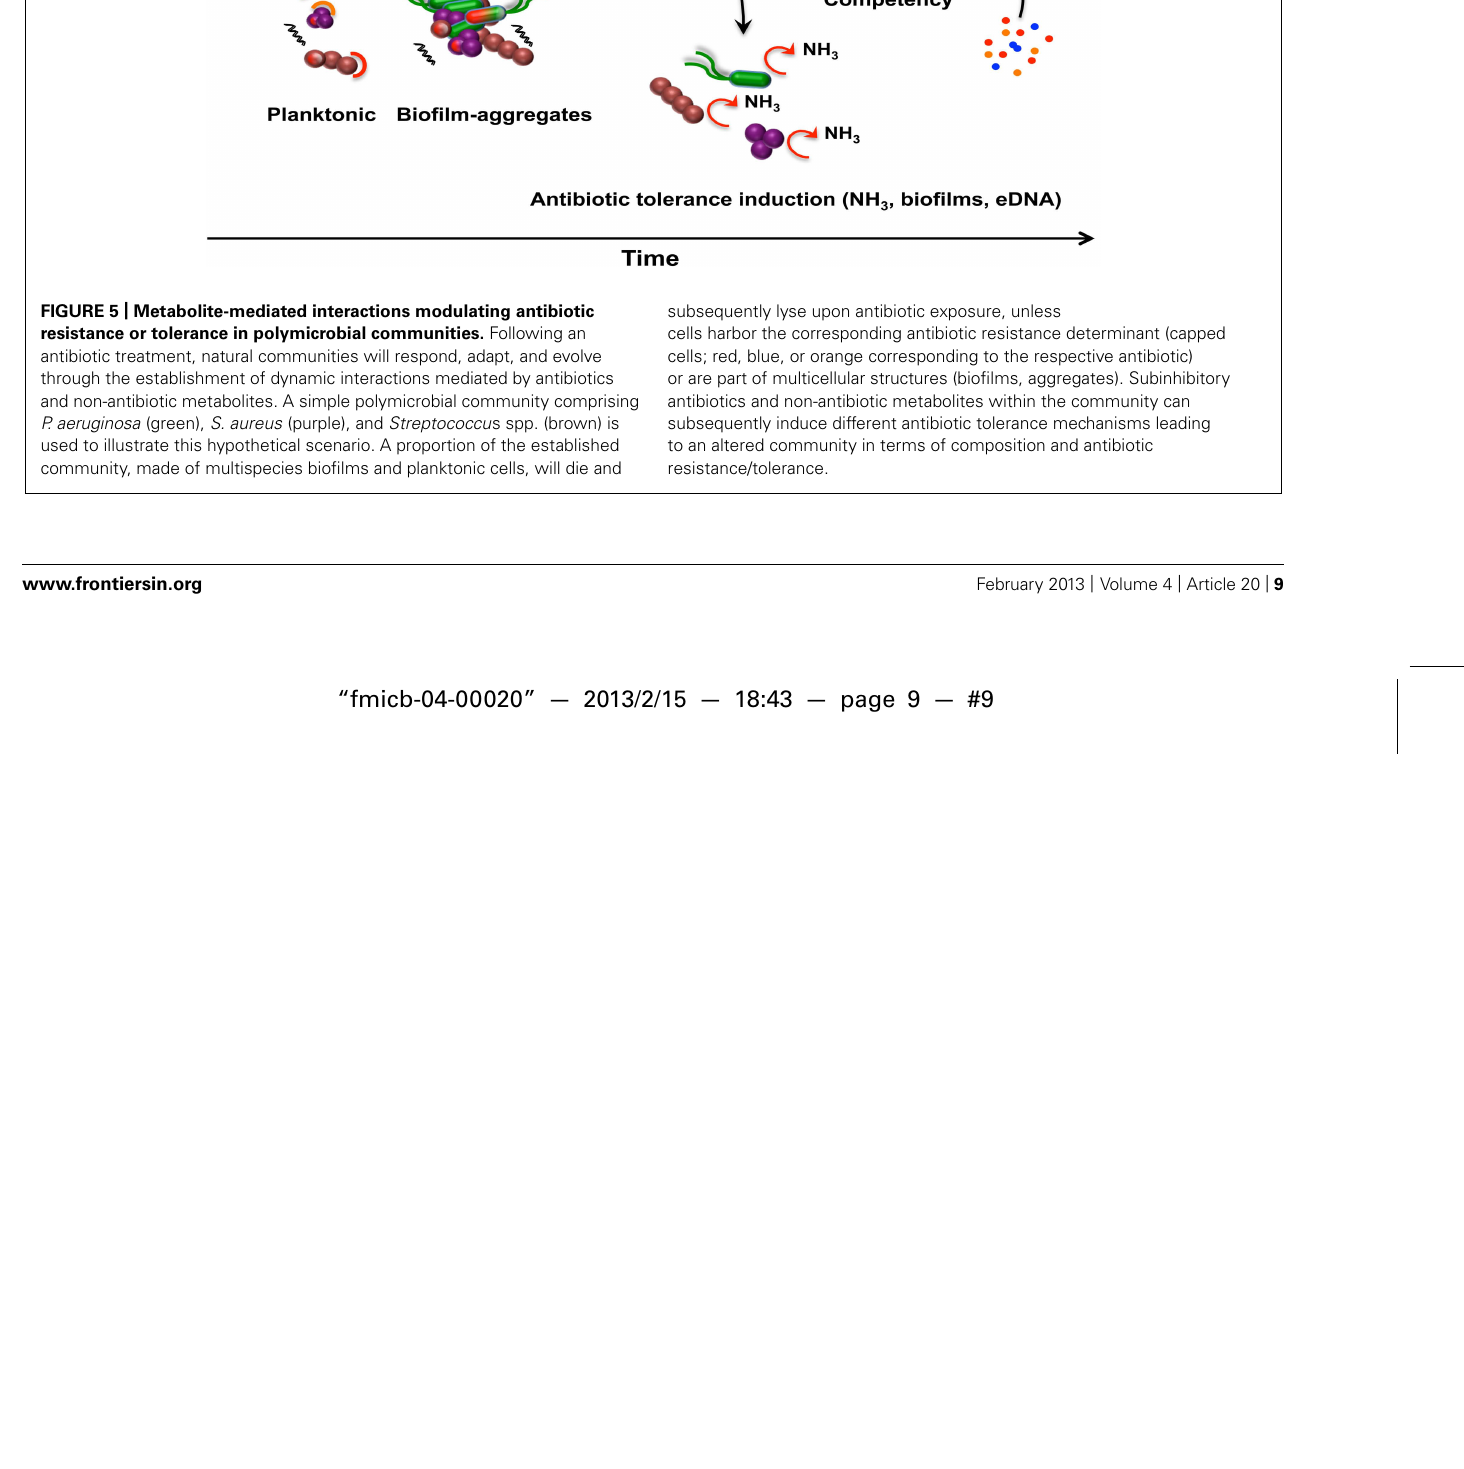
FIGURE 5 | Metabolite-mediated interactions modulating antibiotic resistance or tolerance in polymicrobial communities. Following an antibiotic treatment, natural communities will respond, adapt, and evolve through the establishment of dynamic interactions mediated by antibiotics and non-antibiotic metabolites. A simple polymicrobial community comprising P. aeruginosa (green), S. aureus (purple), and Streptococcu s spp. (brown) is used to illustrate this hypothetical scenario. A proportion of the established community, made of multispecies biofilms and planktonic cells, will die and